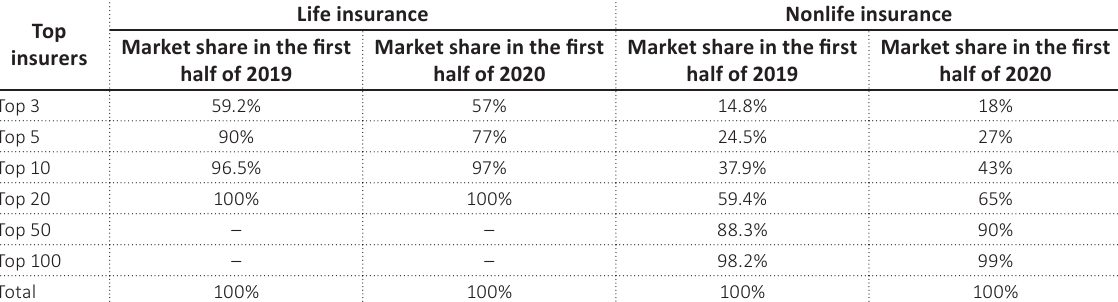
Table 1. Ukrainian insurance market concentration in terms of gross premium